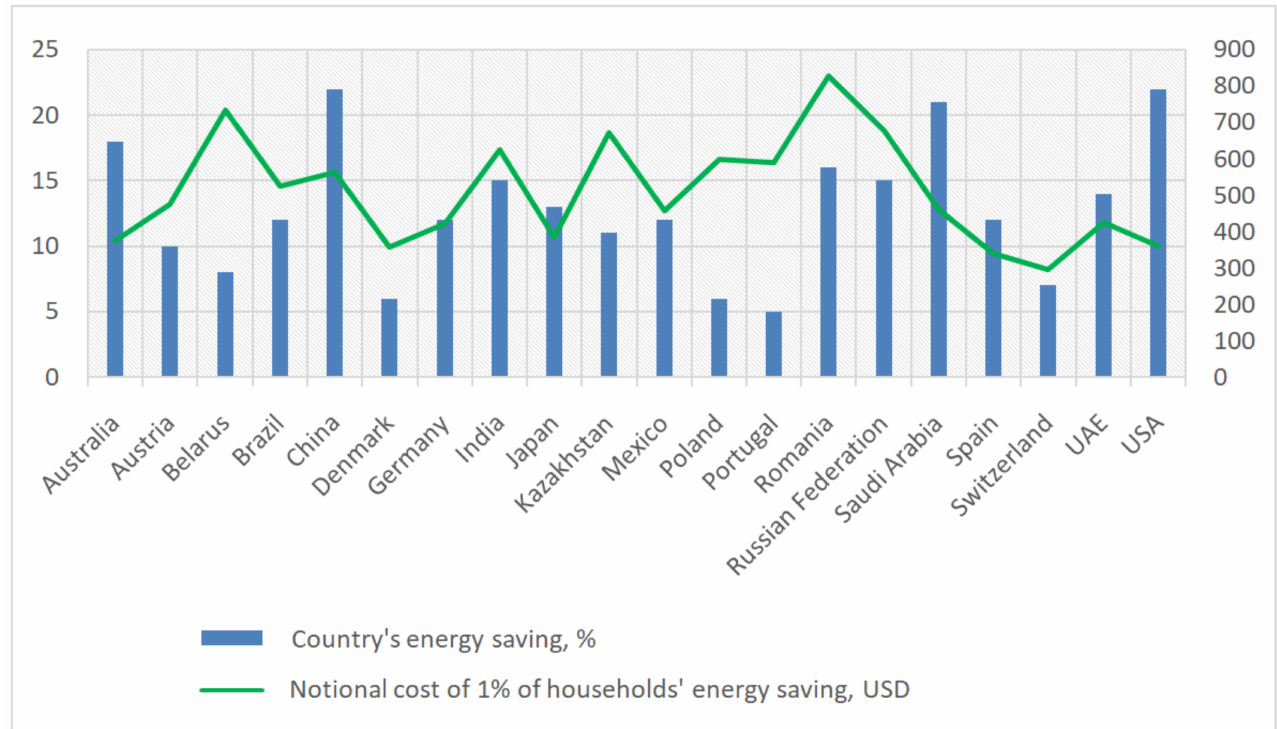
Figure 3. Motivational benchmarks for increasing state’s and household’s energy autonomy. Source: generated by the